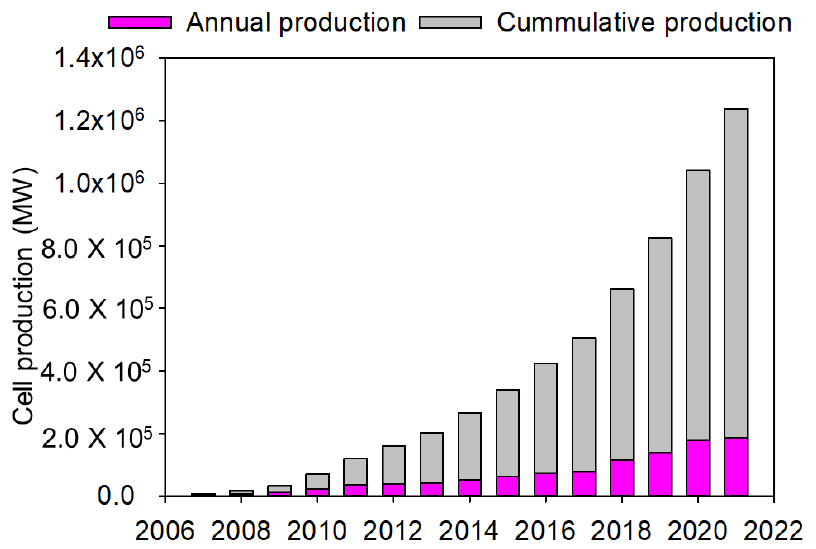
Figure 2. Global annual and cumulative solar PV cell production from 2007 – 2021 [83].